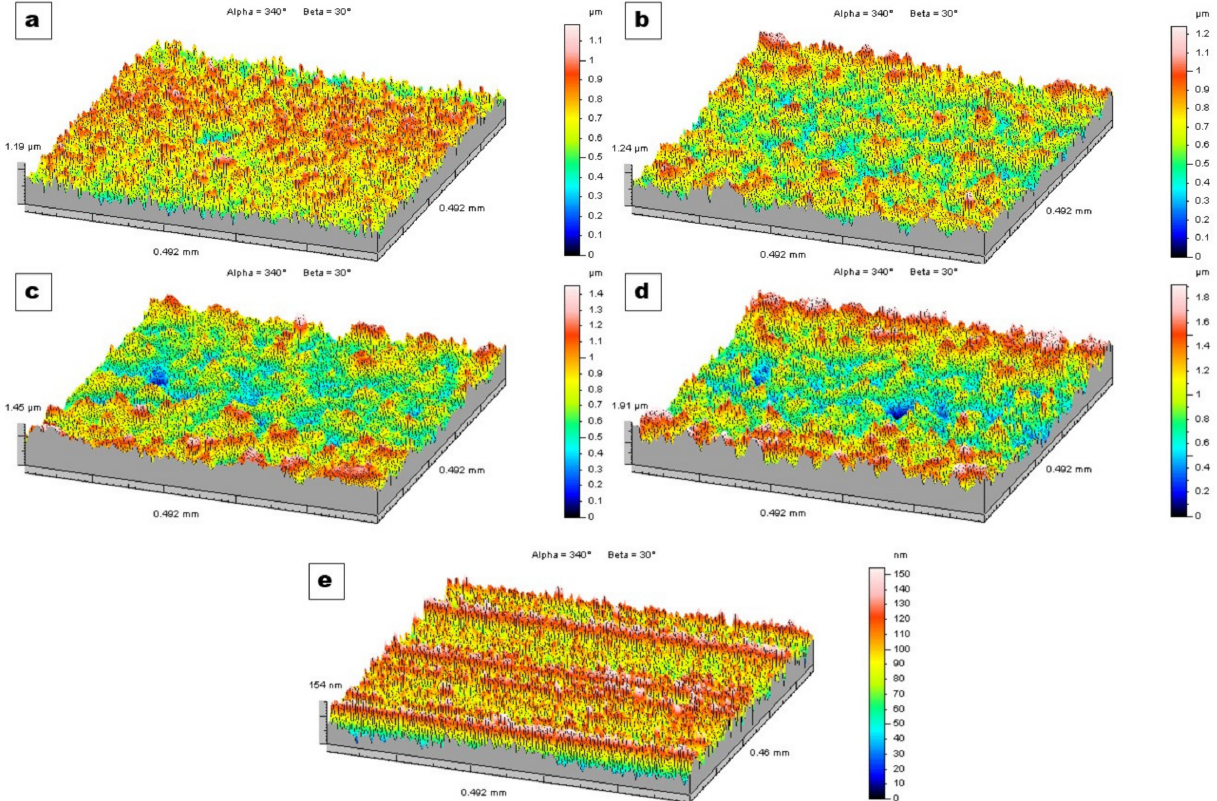
Figure 5. Images of surface morphology of duplex-treated samples depending on PN